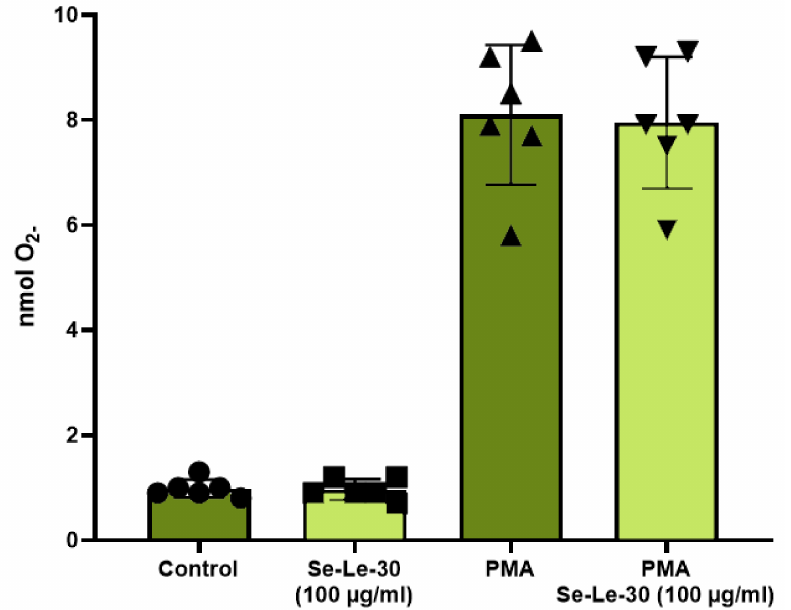
Figure 5. The effect of Se-Le-30 (in the concentration of 100 µ g/mL) on the production of superoxide anions (O 2- ) by human peripheral blood granulocytes. The auto- and phorbol 12-myristate 13-acetate (PMA) stimulation of granulocytes is presented as a concentration of O 2 − determined by cytochrome c reduction rate. p value was calculated for control cultures vs. cultures with Se-Le-30 and PMA stimulated cultures vs. cultures with PMA and Se-Le-30. The mean value ( n = 6) and standard deviation are